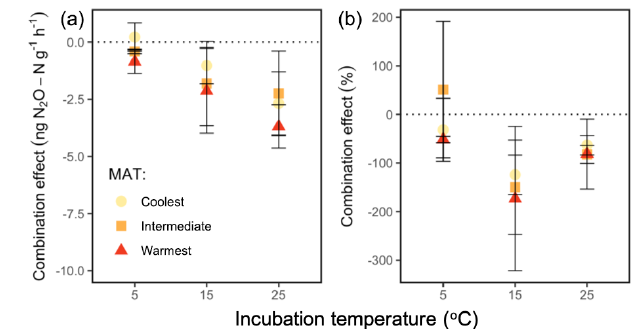
Figure 4. The combination effect of shared headspace surrounding physically separated organic and mineral horizons on the absolute net N 2 O flux (a) and as a percentage of the expected N 2 O pro- duction rate (b) , at the end of a 60h incubation at 5, 15, and 25 ◦ C, for soils from three regions along a boreal forest latitudinal transect. The combination effect (negative denotes reduction) is calculated as the difference between observed net N 2 O fluxes when soil horizons shared the incubation headspace (observed) and the linear, additive effect of rate differences between horizons in separate headspaces (((organic + mineral) / 2) = expected). The percent combination ef- fect was calculated as ((observed − expected) / expected) × 100. The nonzero values suggest that the shared headspace generated a non- linear, interactive effect on net N 2 O effluxes. “MAT” refers to the mean annual temperature. The “coolest” region is the Eagle River watershed (northern boreal), the “intermediate” region is the Salmon River watershed (mid-boreal), and the “warmest” region is the Grand Codroy watershed (southern boreal). See the text for site descriptions. Values are provided as the mean ± 1SE ( n = 3 forests per latitudinal